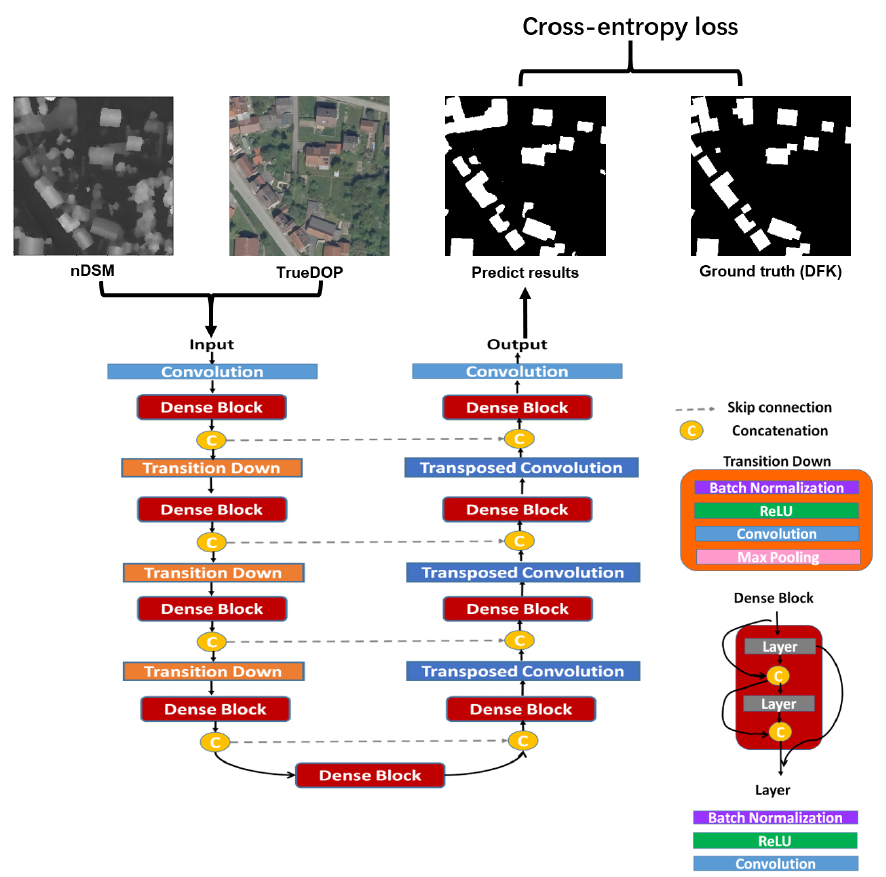
Figure 2. The implemented CNN architectures: